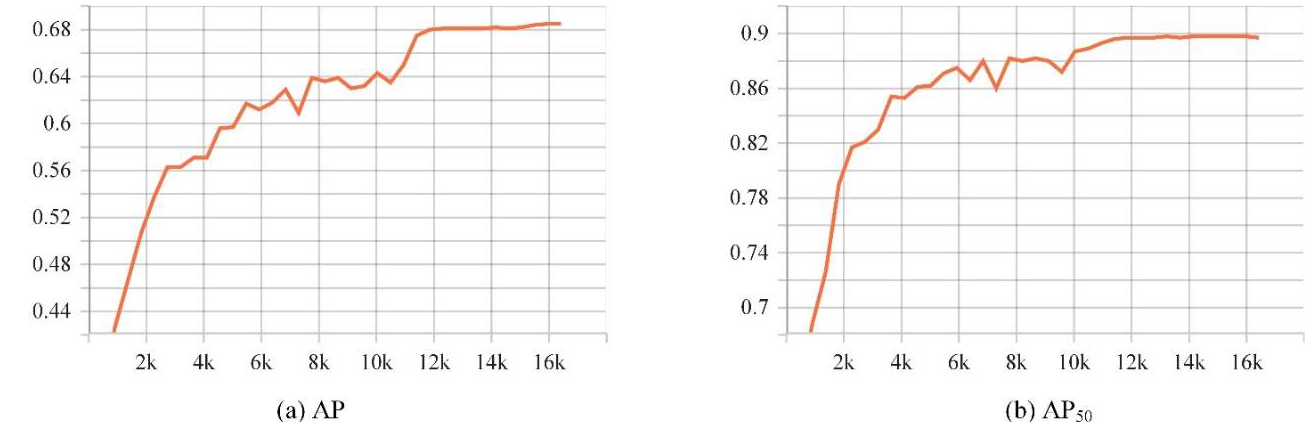
Figure 9. The detection results on the validation set. ( a ) AP. ( b ) AP 50 .